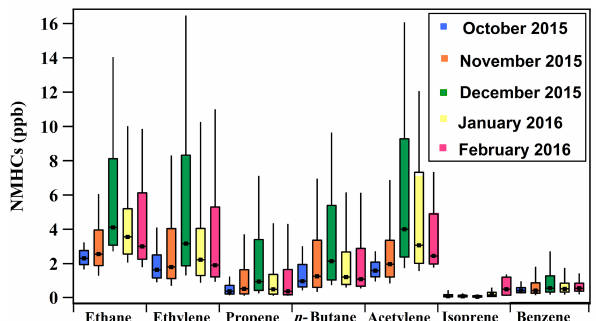
Figure 3. Monthly box plots for ethane, ethylene, propene, n- butane, acetylene, isoprene and benzene. The black dots represent the median values and the boxes shows the interquartile range. The bottom and the top of the boxes depict the first and third quartiles (i.e., Q1 and Q3). The whiskers correspond to the first and the ninth deciles (i.e., D1 and D9).